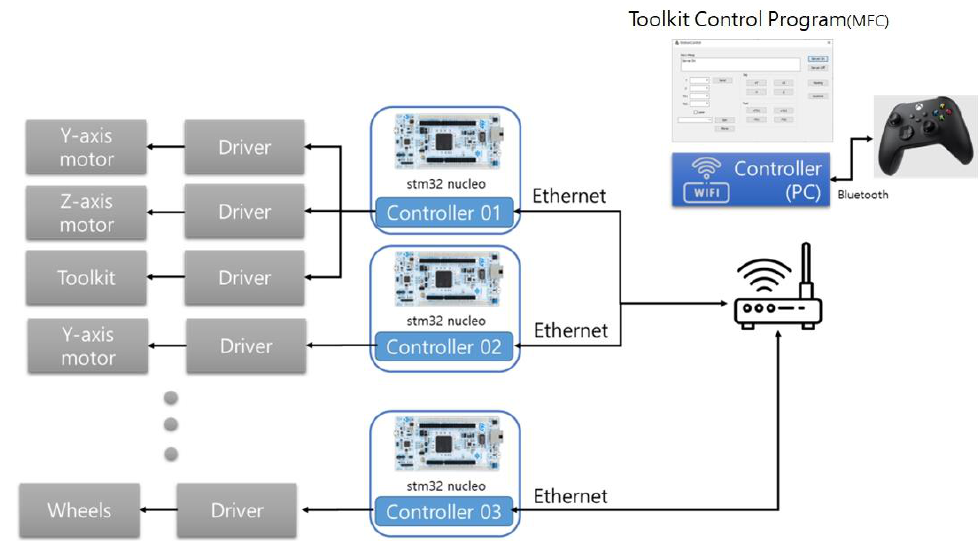
Figure 14. Overall system diagram .